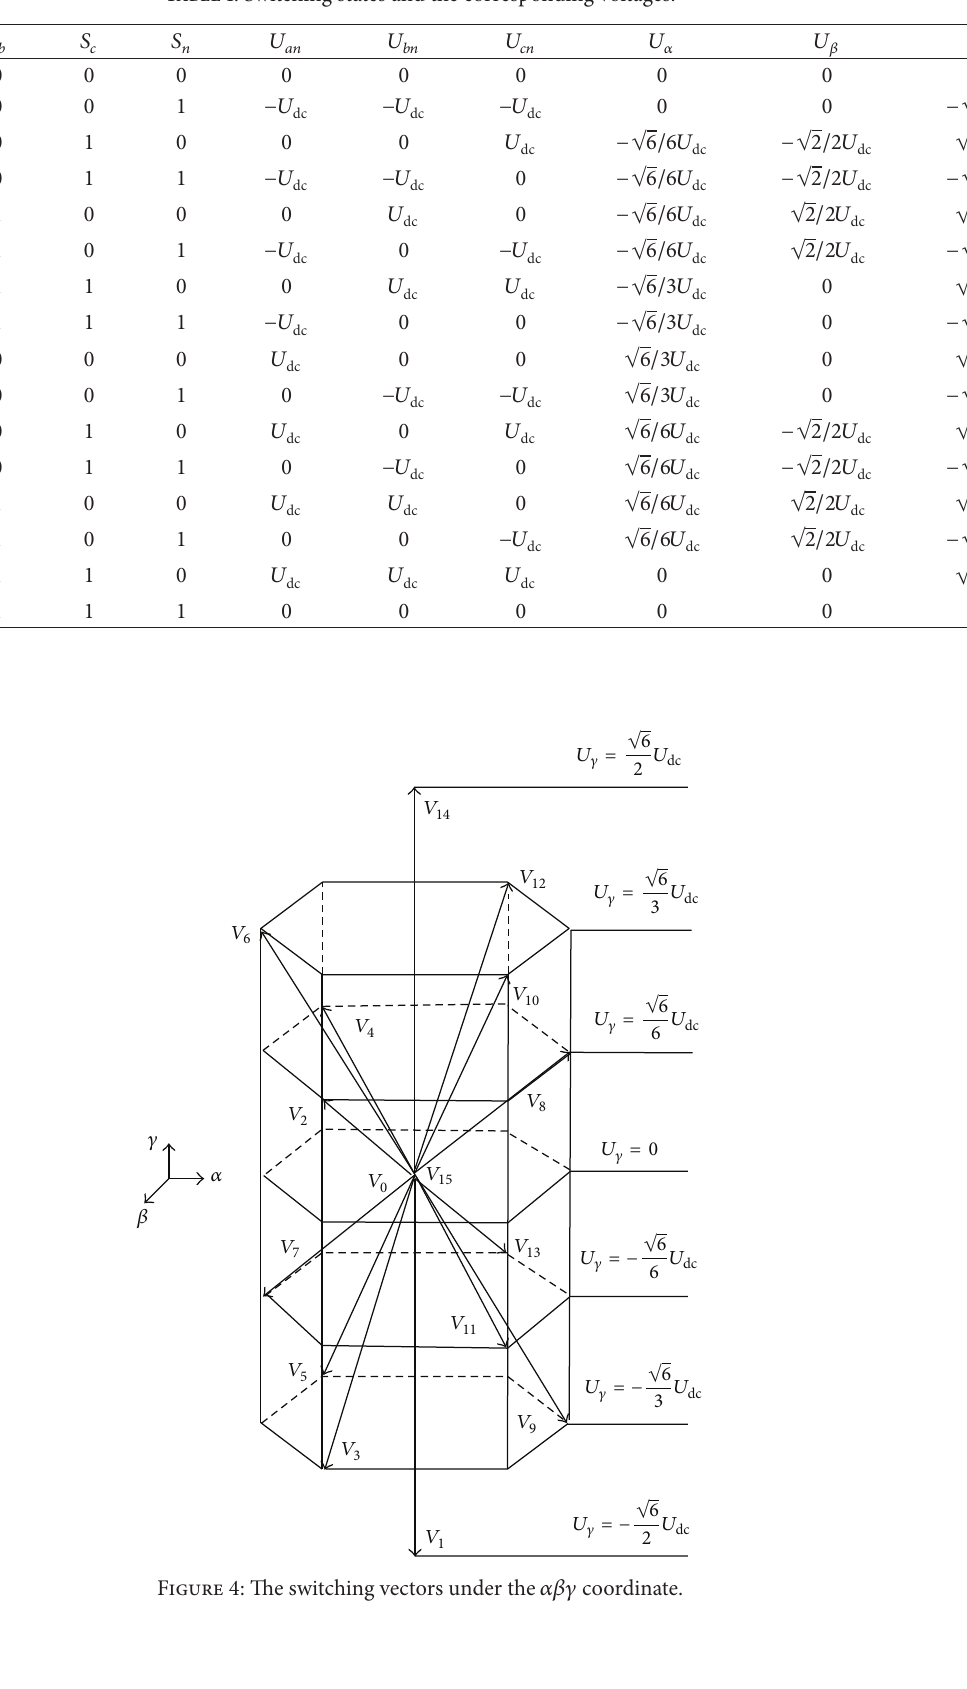
Table 1: Switching states and the corresponding voltages.